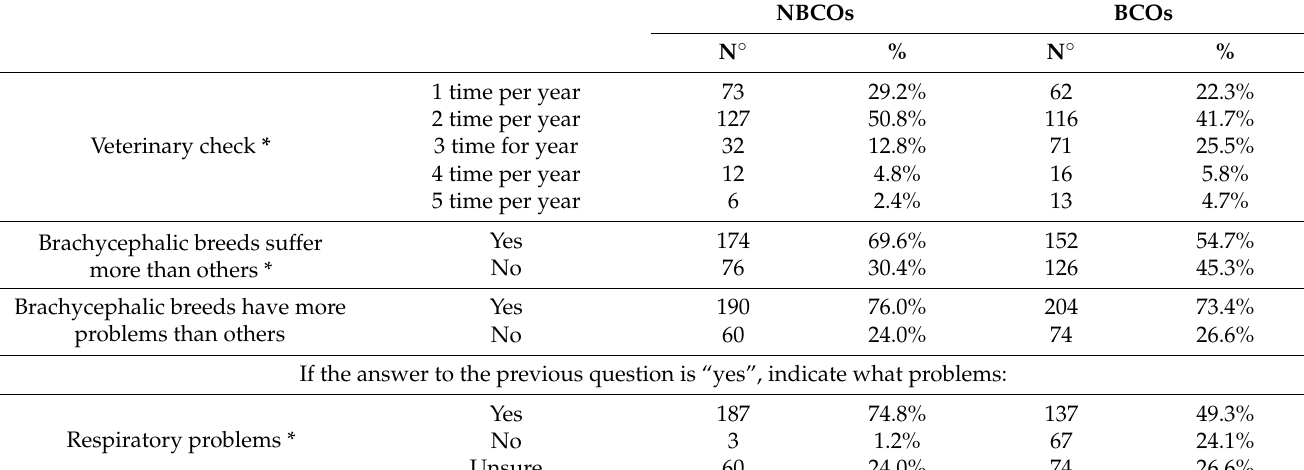
Table 3. Differences in responses between NBCO and BCO (NBCO: Non-Brachycephalic Cat Owners; BCO: Brachycephalic Cat